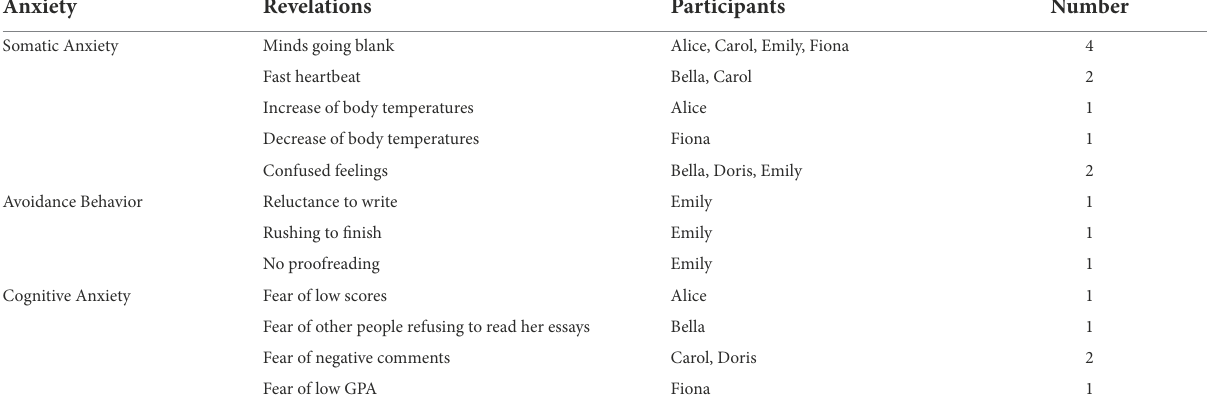
TABLE 1 Participants’ experiences of second language writing anxiety